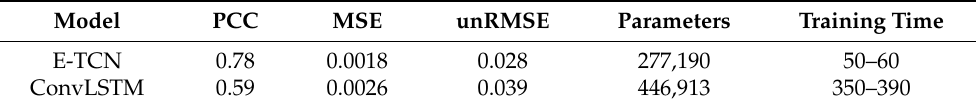
Table 5. The average PCC, MSE and ubRMSE between the predicted values and the ground truth over the 25 predicted images. This table also illustrates the number of trainable parameters and the training time in msec per step both for the E-TCN and the ConvLSTM mode when the dataset consisted of images of 140 × 140 pixels.